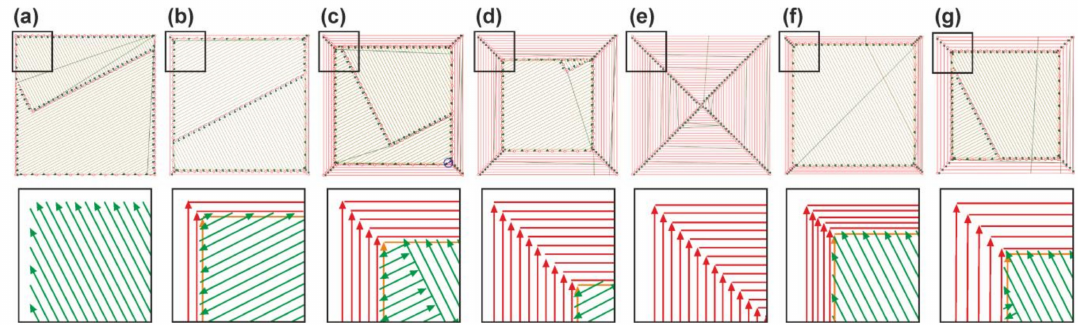
Figure 2. Examples for di ff erent scan patterns (bottom images represent enlargements of the top left corner in the upper sketches): ( a ) only chess pattern used (contour line with P = 0 W); ( b ) 2 contour lines (h = 90 µ m); ( c ) 5 contour lines (h = 90 µ m), ( d ) 10 contour lines (h = 90 µ m); ( e ) only contour lines (h = 90 µ m); ( f ) 5 contour lines with a small hatch distance of h = 60 µ m; ( g ) 5 contour lines with a large hatch distance of h = 120 µ m.